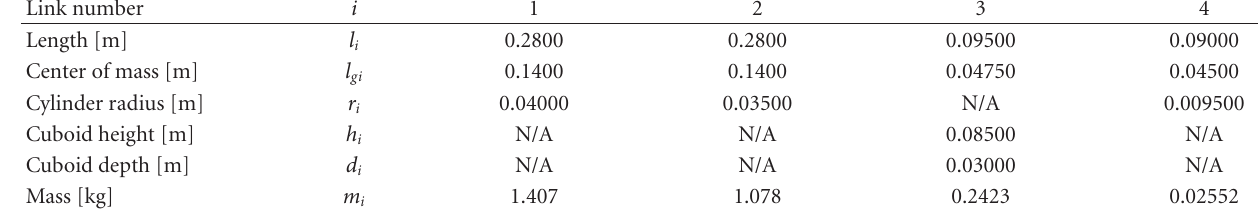
Table 1: Physical parameters of the 4-DOF robot arm.